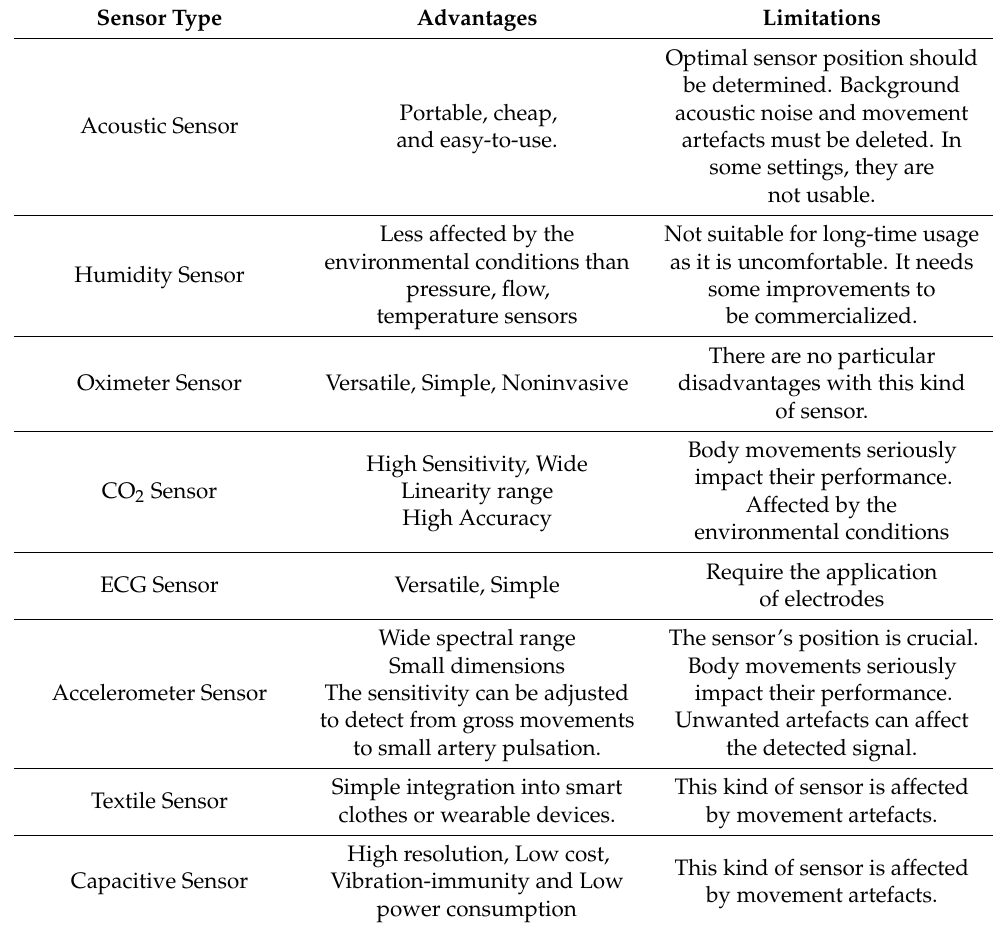
Table 1. Table with summarized the main wearable technologies used to detect the respiration